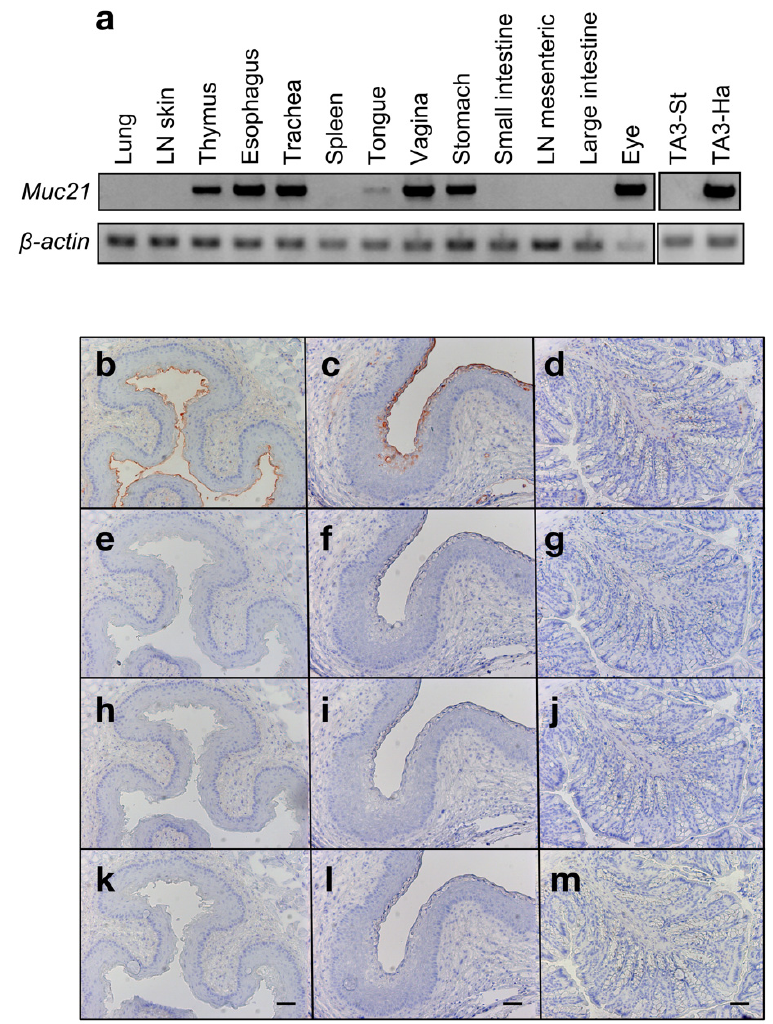
Figure 6. Muc21 mRNA expression in a panel of normal mouse tissues and immunohistochemical staining of selected normal mouse tissues with mAb 1A4-1 ( a ) Muc21 mRNA expression in a panel of C57BL/6J mouse tissues. TA3-St cells and TA3-Ha cells were used as controls ( b – d ) Sialidase-treated mouse tissue sections stained with mAb 1A4-1. ( b ) Esophagus. ( c ) Vagina. ( d ) Large intestine. ( e – g ) Untreated mouse tissue sections stained with mAb 1A4-1. ( e ) Esophagus. ( f ) Vagina. ( g ) Large intestine. ( h – j ) Sialidase-treated mouse tissue sections stained with hamster IgG. ( h ) Esophagus. ( i ) Vagina. ( j ) Large intestine. ( k – m ) Untreated mouse tissue sections. Buffer (no primary antibody) control. ( k ) Esophagus. ( l ) Vagina. ( m ) Large intestine. ( b – m ) Scale bar: 50 μ m. LN; lymph node.